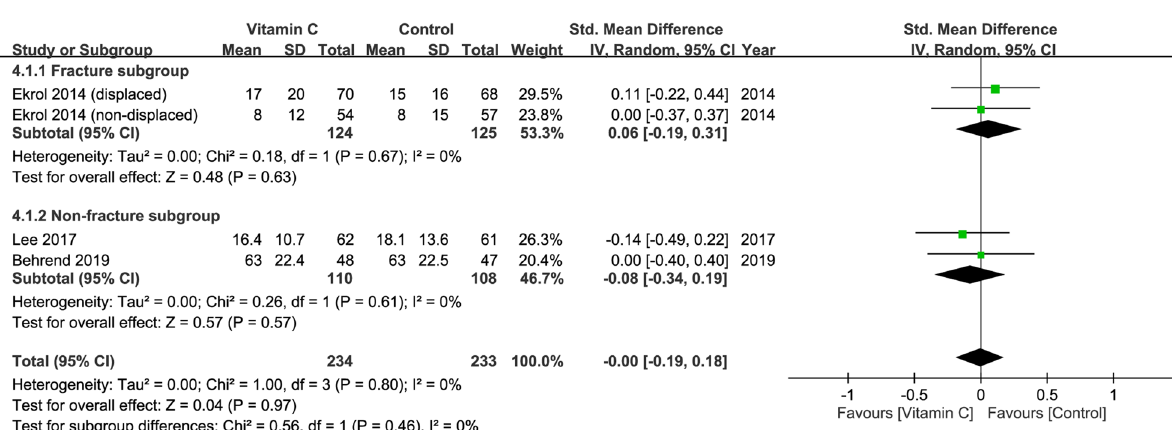
Figure 3. Forest plot for the comparison of function outcomes at 3–6 months between vitamin C and placebo groups. CI, confidence interval; IV, inverse variance; Std., standardized.